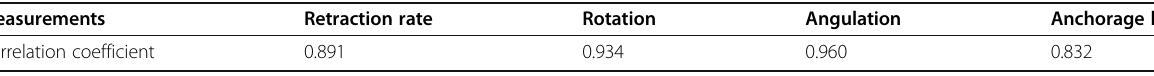
Table 1 Intraclass correlation test